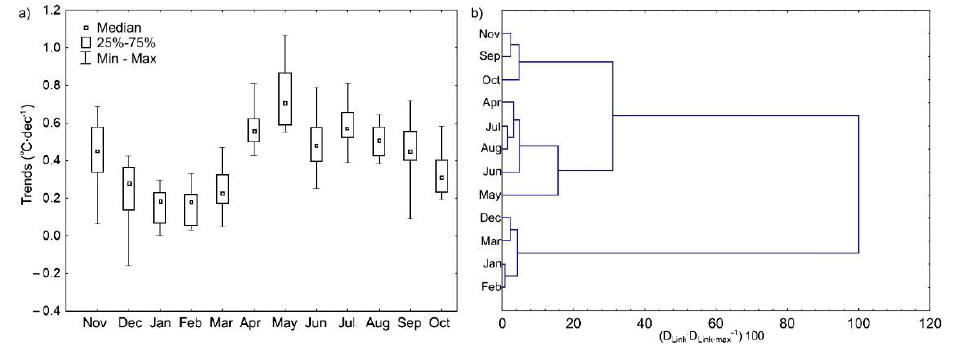
Figure 4. Monthly trends of water temperature in lakes ( a ) and results of grouping months based on trends by means of the cluster analysis (CA) method ( b ).